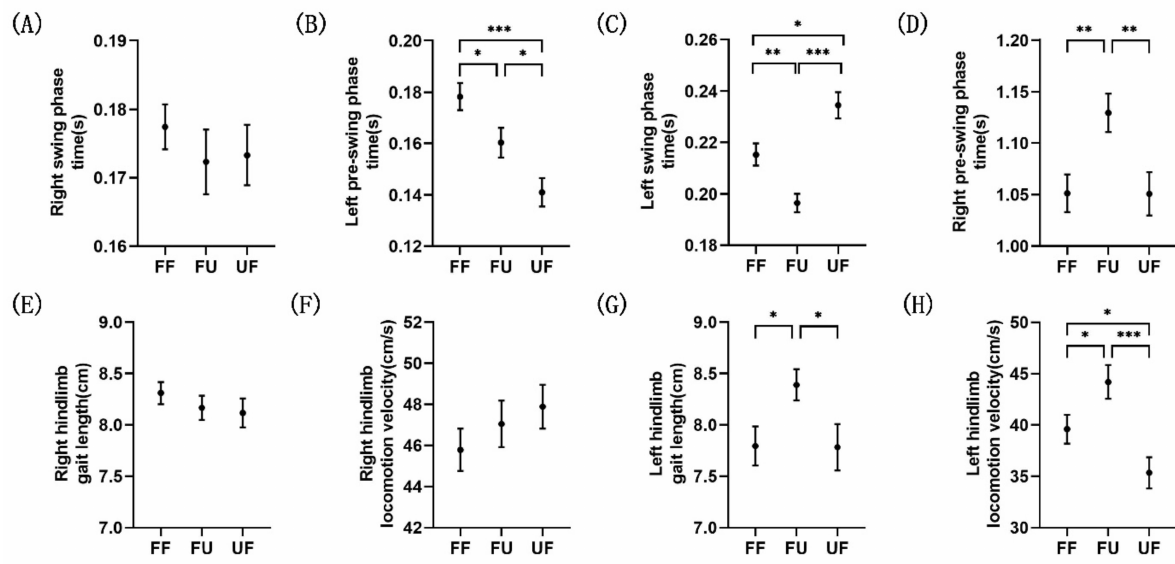
Figure 3. Rat hind limb motion patterns. ( A – D ) The mean time spent in the right swing phase, left pre-swing phase, left swing phase, and right pre-swing phase. ( E , F ) The mean gait length and mean locomotion velocity of the right hind limb in the right swing phase. ( G , H ) The gait length and locomotion velocity of the left hind limb in the left swing phase. All error bars indicate 1 SE. ( n = 4 animals; * p < 0.05; ** p < 0.01; *** p < 0.001). Table 1. Hind limbs kinematics data (mean ± SEM) of each gait phase. Right Swing Phase Left Pre-Swing Phase Left Swing Phase Right Pre-Swing